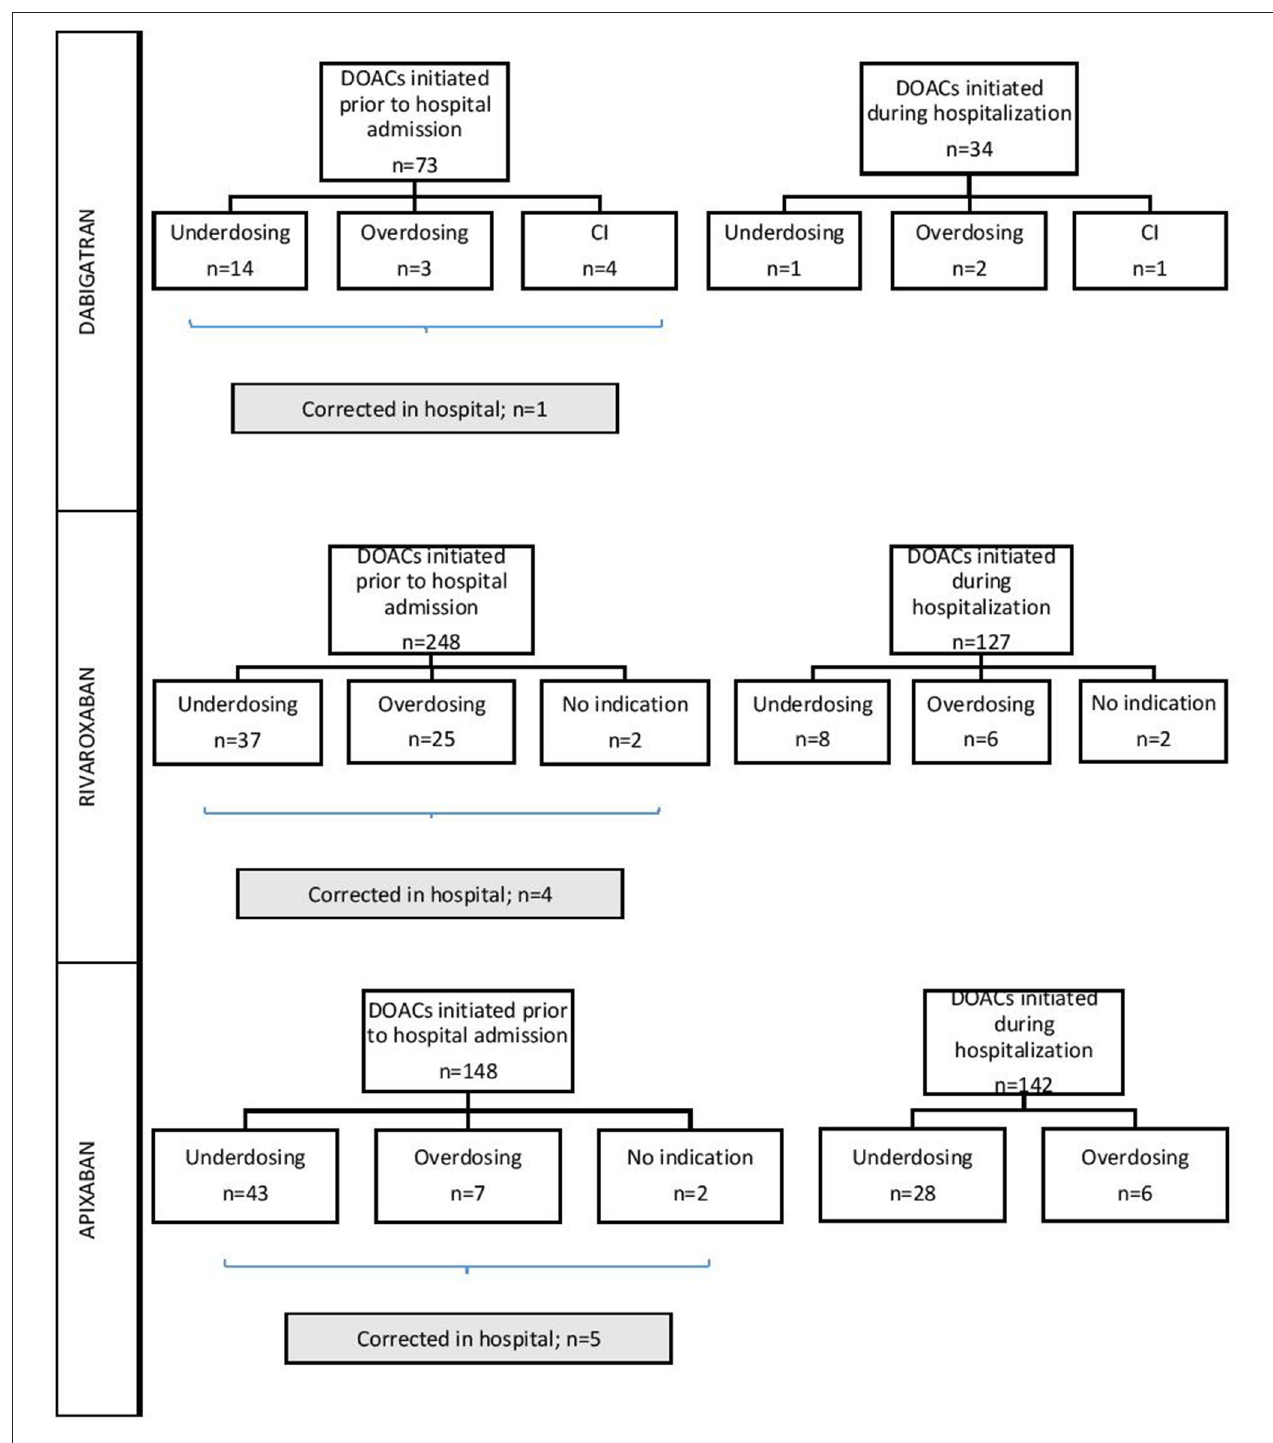
FIGURE 2 | Inappropriate prescribing of dabigatran, rivaroxaban, and apixaban depending on the initiation setting. DOAC, direct oral anticoagulant; CI, contraindication.